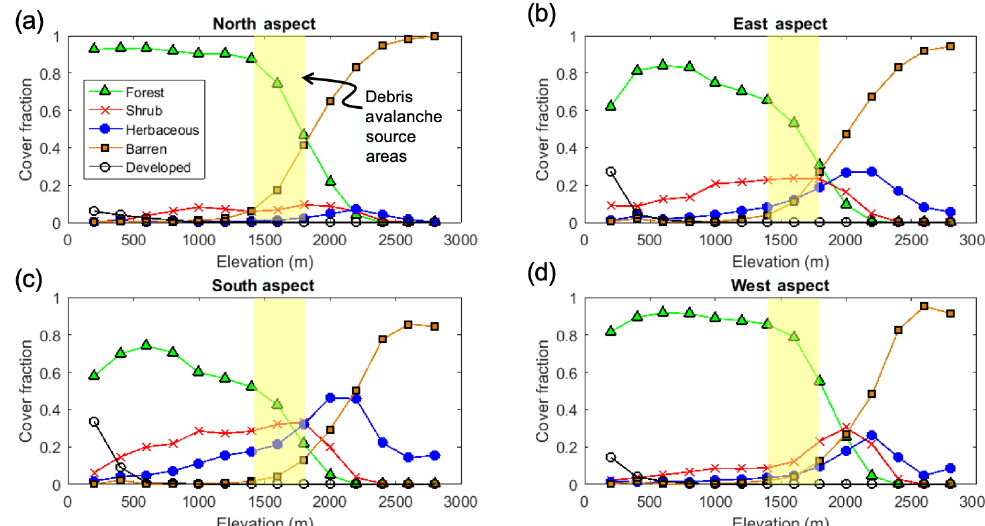
Figure 5. Vegetation cover fraction in NOCA on each aspect, taken as the fraction of vegetation type within each 200m elevation band. Aspects categorized here as (a) north (0 to 45 ◦ and 315 to 360 ◦ ), (b) east (45 to 135 ◦ ), (c) south (135 to 225 ◦ ), and (d) west (225 to 315 ◦ ) cover 23%, 23%, 26%, and 28% of NOCA, respectively. Yellow highlighted area represents the strongest elevation association for debris avalanche source